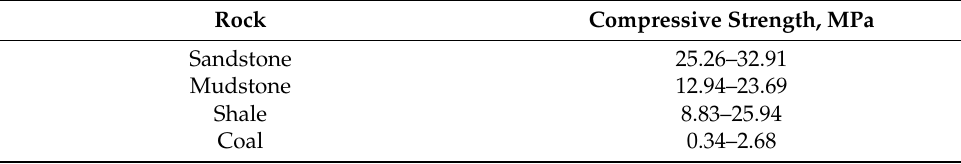
Table 2. Compressive strength of coal and surrounding rocks of 403/1 coal